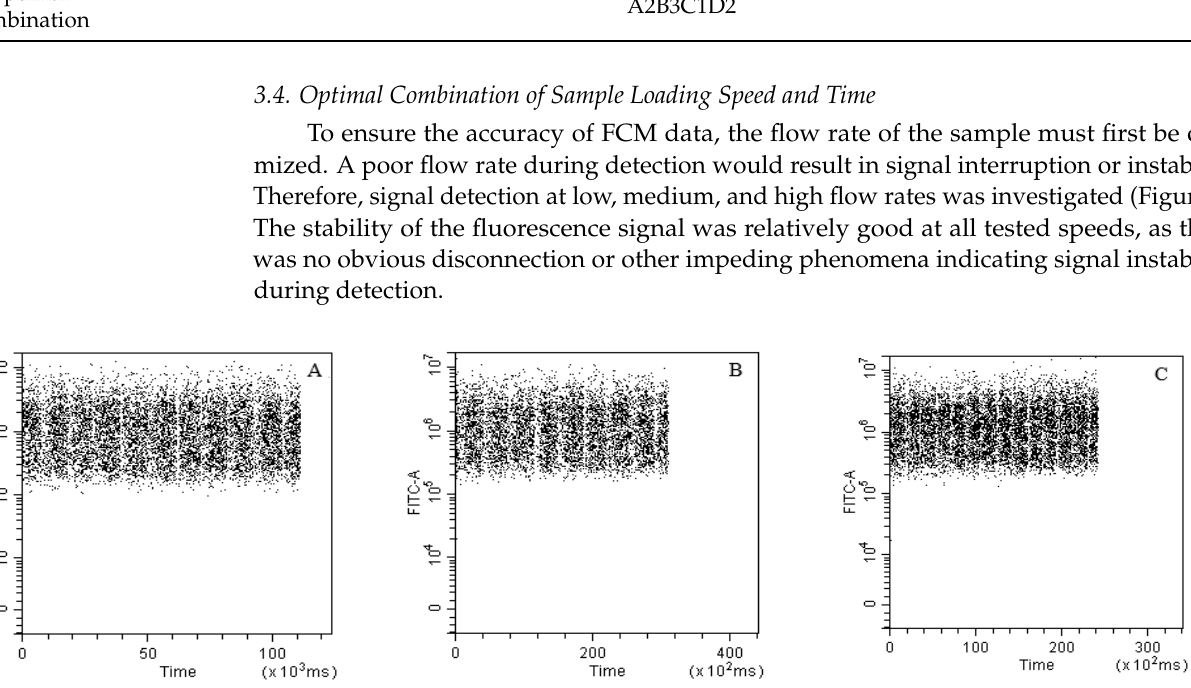
Figure 3. Flow cytometer flow rate fluorescence signal dot plots. ( A ) Low speed; ( B ) medium speed; and ( C ) high speed.